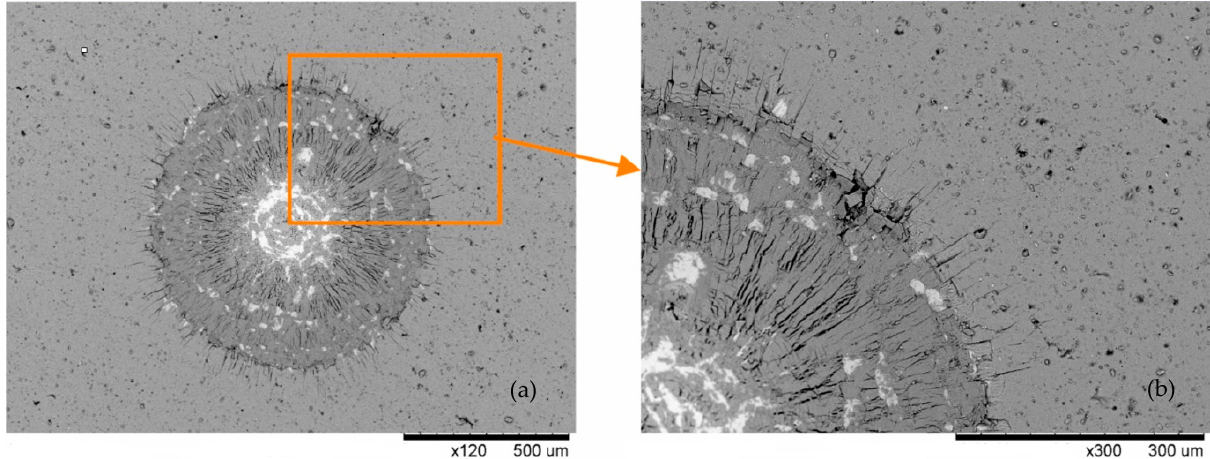
Figure 4. The adhesion results by using the indentation method of Cr/CrN coating. ( a ) contact zone; ( b ) edge of contact zone.